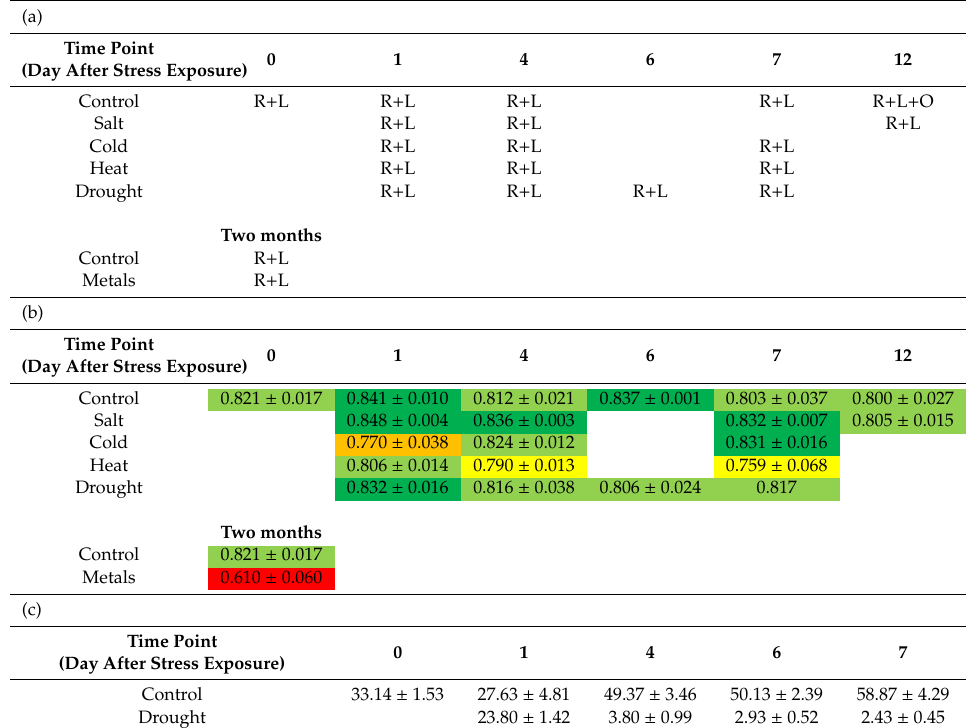
Table 1. ( a ) Sampling time of the di ff erent organs of 8 months old willows exposed to di ff erent abiotic stress factors for 12 days. R: roots, L: leaves, O: other organs (roots stele, roots cortex, stem xylem and bark). ( b ) Evolution of the F V / F M ratios during the time course of the experiment. Values given are the averaged F V / F M ratios ± standard deviation of the measures made on three biological replicates. On day 7, only one plant exposed to drought stress still had its leaves. Dark green, F V / F M ratio between 0.825 and 0.850; light green, 0.800–0.825; yellow, 0.775–0.800; orange, 0.750–0.775; red, F V / F M ratio under 0.750. ( c ) Evolution of the soil relative water content (RWC) in the soil of control and drought-exposed plants. Plants exposed to salt, cold, and heat stress were watered at the same frequency as control